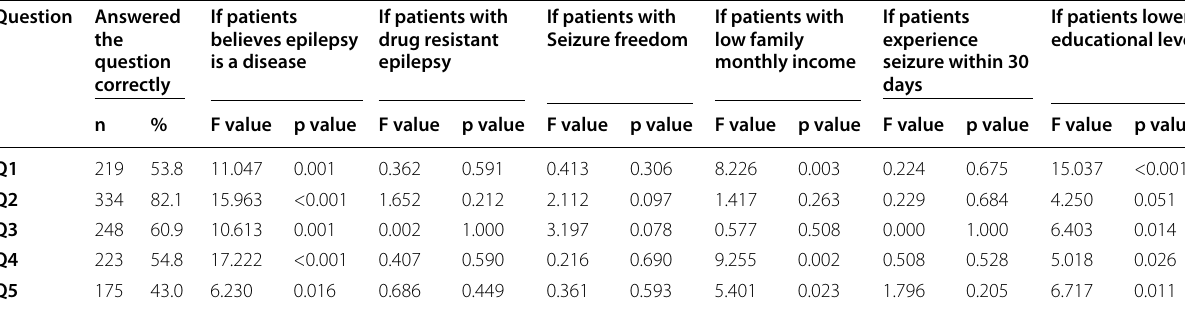
Table 2 Response about epilepsy treatment between different subgroups Question Answered the